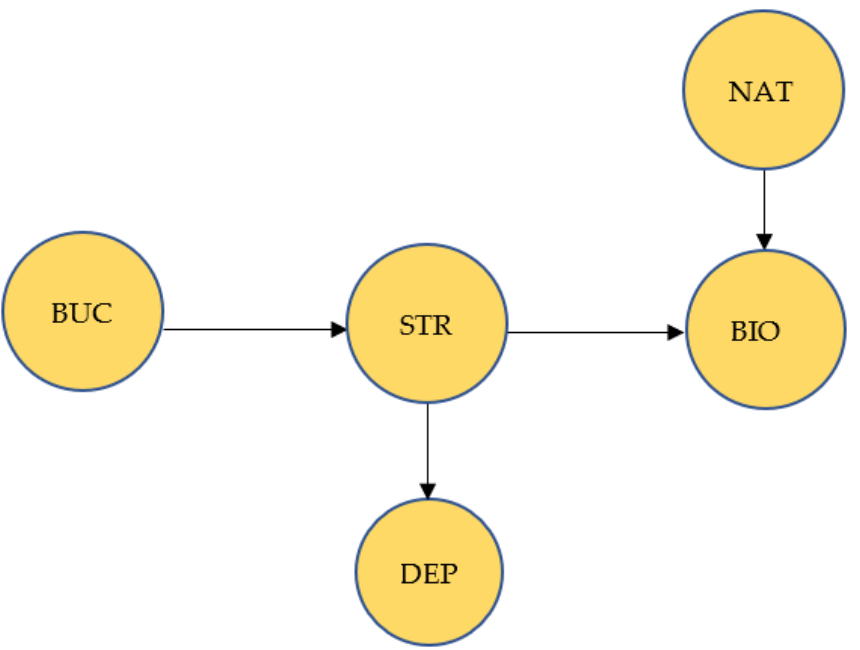
Figure 1. The conceptual framework of the tested model. BUC = burden of COVID-19, STR = perceived stress, DEP = depression, BIO = preferences for biophilic design, NAT = perceived benefits of nature.